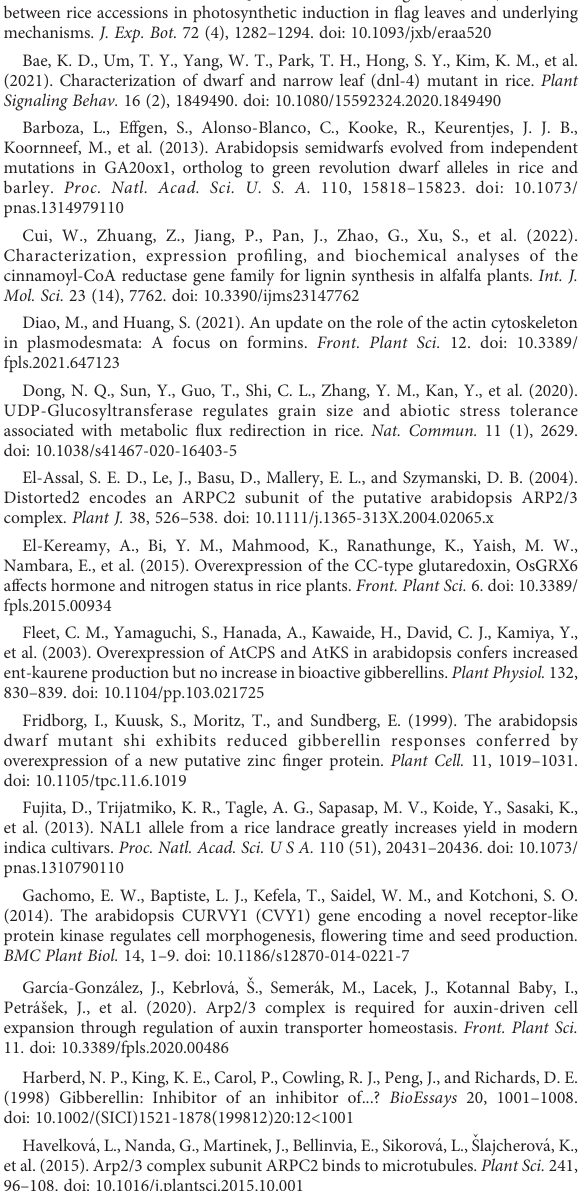
with1,10,20mg/LofGA3ordistilledwater(0ppm)orcontrolplantwerenot treated with GA and water (Con). (C, D) All treated plants were measured height of plant. Each treated group had 15 plants and experiments were repeated three times. Asterisks indicate statistically signi fi cant differences between the corresponding samples and their control (p-value<0.1, Student ’ s t-test). SUPPLEMENTARY FIGURE 4 Generation of transgenic rice plants overexpressing OsGASD gene. (A) Structure of the construct is show. LB, left border; RB, right border, HPT,